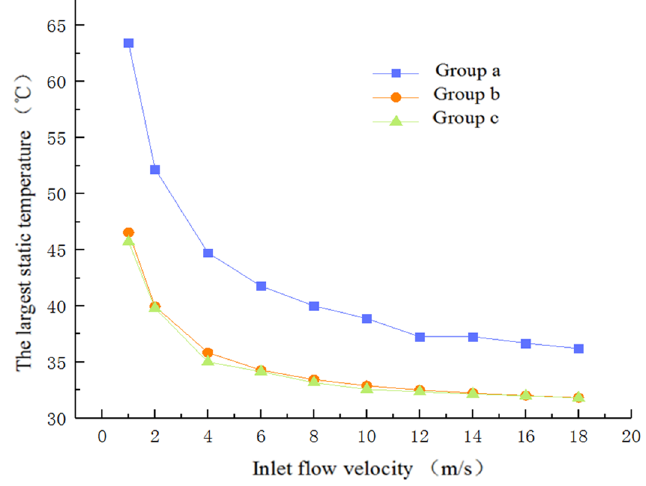
Figure 7. Relationship between cooling water inlet flow rate and maximum static temperature of water ‐ cooled plate surface.